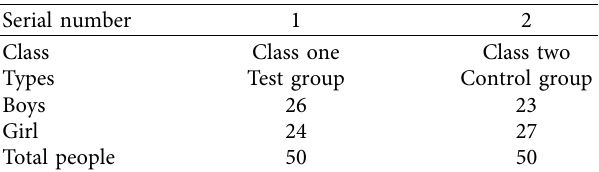
Table 2: Independent sample t -test of experimental class and control